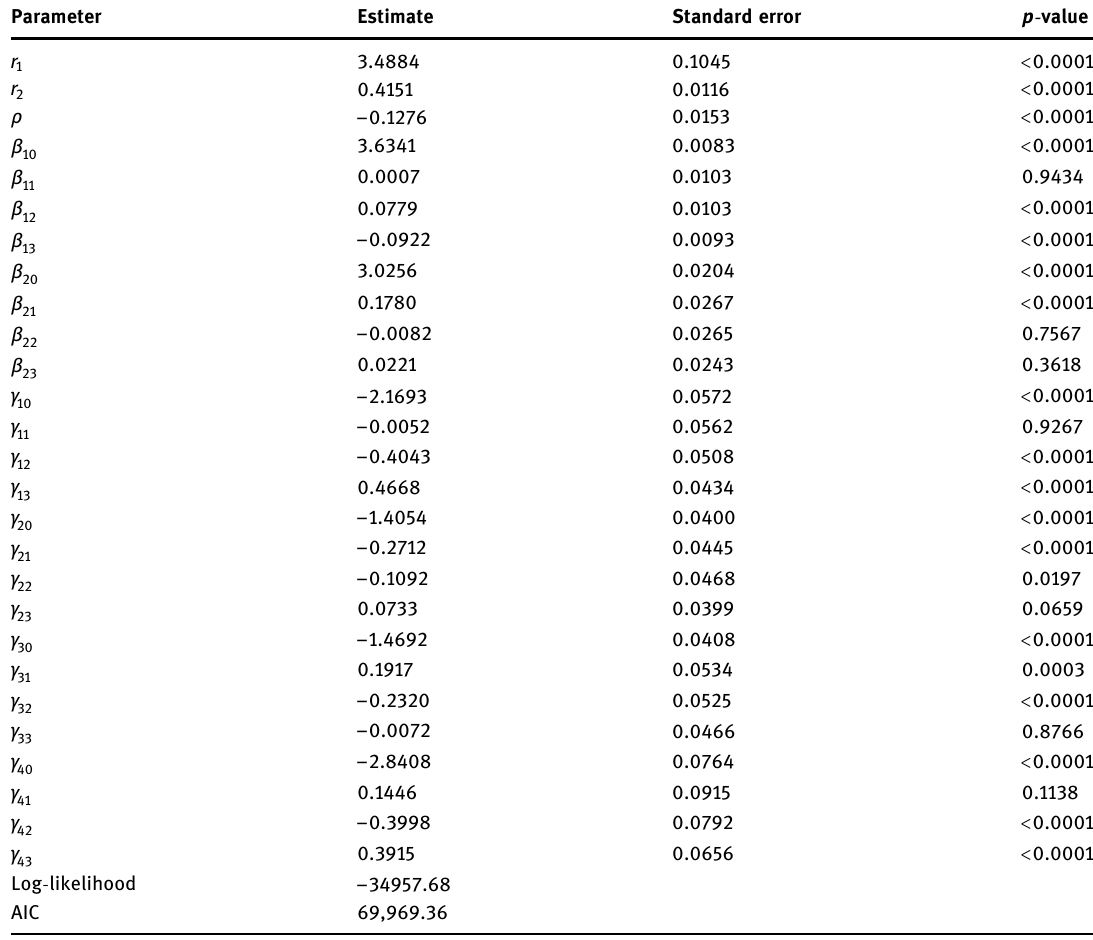
Table 8: Parameter estimates for